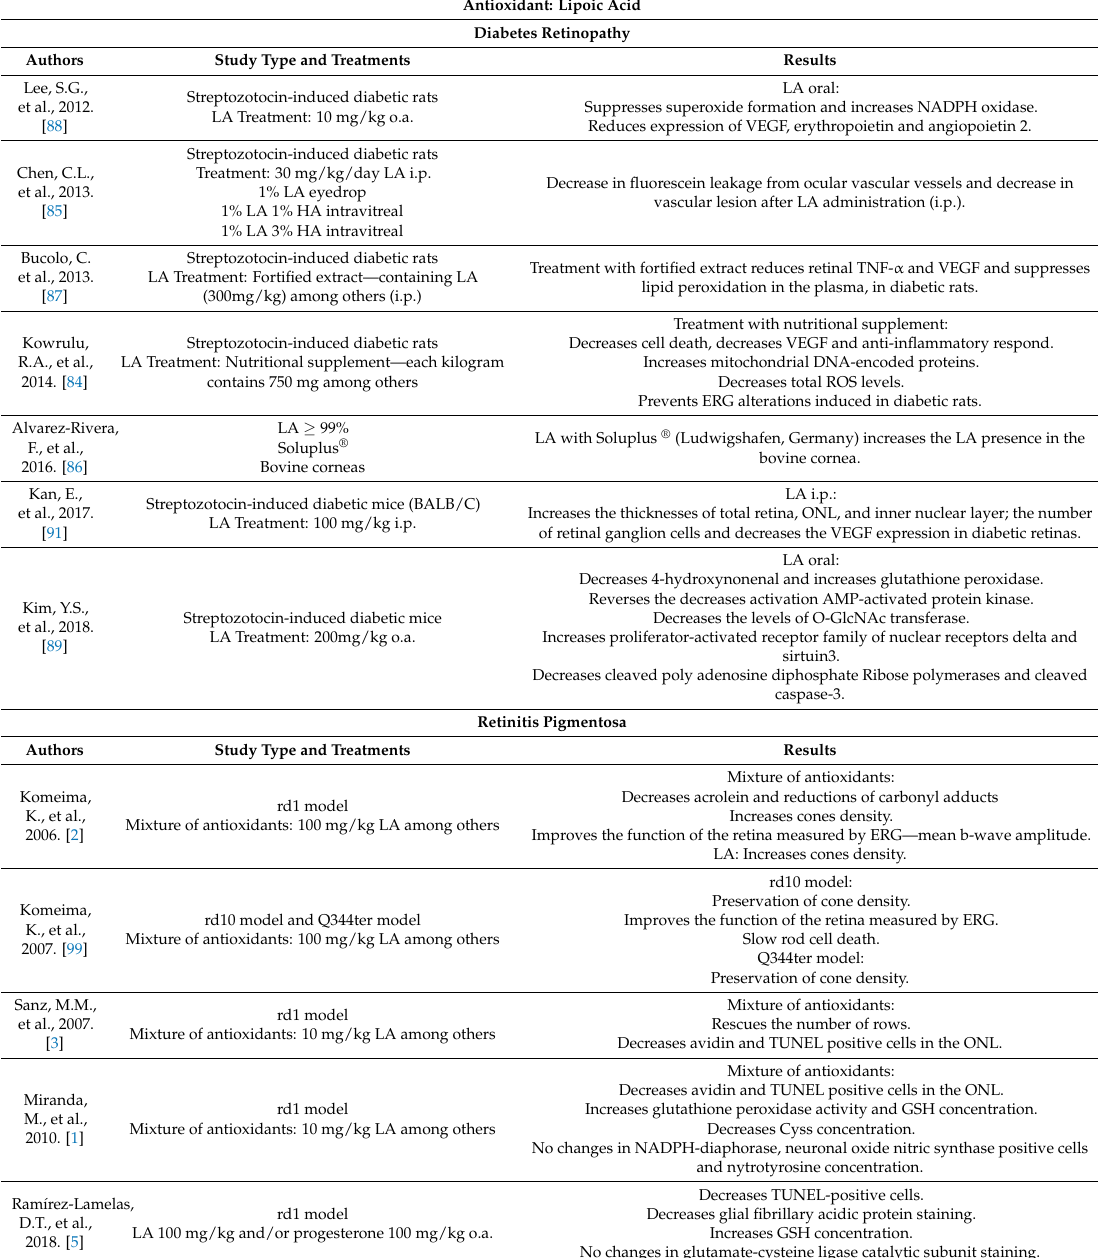
Table 2. Antioxidant effects of lipoic acid in experimental models of retinal